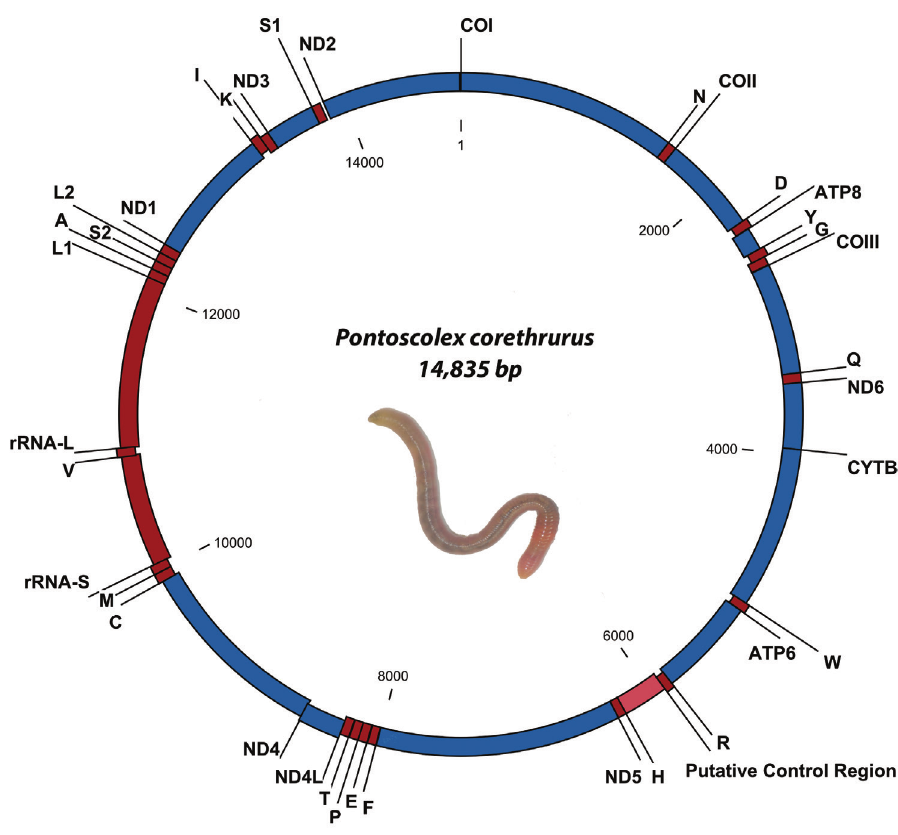
Figure 1. The mitochondrial genome of Pontoscolex corethrurus (Müller, 1857). Gene order and positions are shown, including the putative control region. IUPAC single letter codes are used to identify transfer RNA. The L1, L2, S1, and S2 transfer RNAs are differentiated on the basis of their anti-codons TAG, TAA, TCT, and TGA,